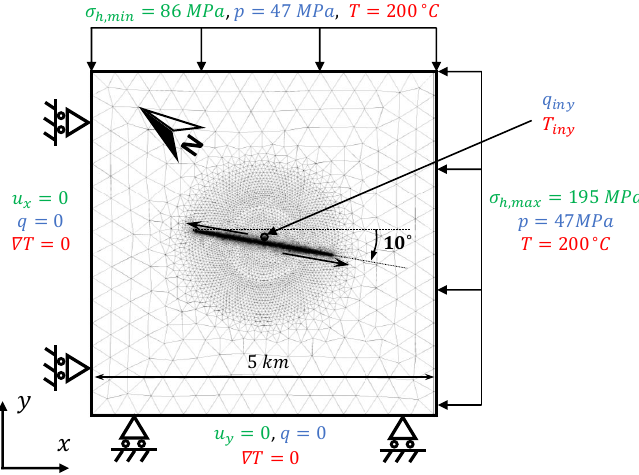
Figure 1. Scheme of the 2D Basel EGS model. We show the model domain, a 5 km 2 square with a strike-slip fault of 2 km length oriented 10 ◦ with respect to the x -axis. The domain is a horizontal section of the reservoir located at 4800 m depth, with an injection well of 5 m radius located at 50 m from the midpoint of the fault. The figure also includes the boundary conditions applied: tectonic stresses, hydrostatic pore pressure, and natural temperature on NE and SE boundaries; normal displacements, thermal transport, and fluid flow impeded on NW and SW